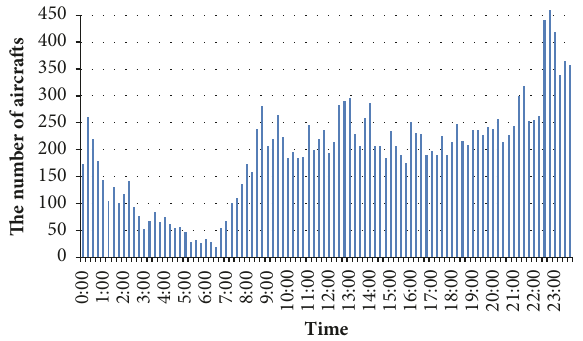
Figure 2: Bar chart of aircraft in Sector AR05 in central and southern China in different periods in May.